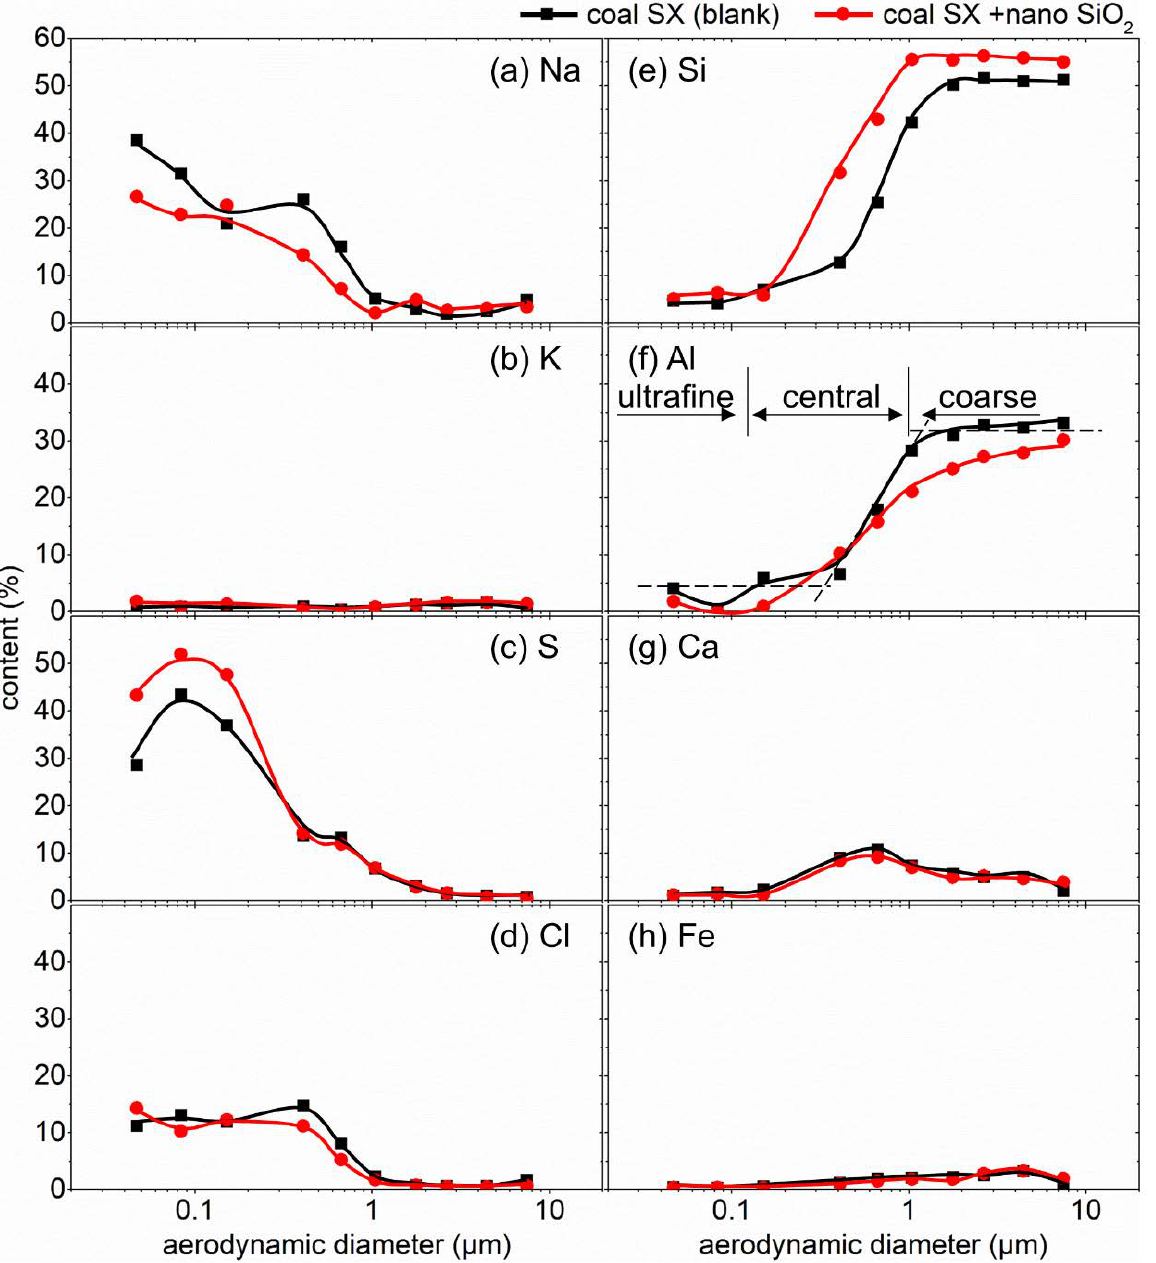
Figure 3. Size-resolved elemental composition distribution in PM 10 generated from coal SX combus- tion with/without nano SiO 2 addition: ( a ) Na; ( b ) K; ( c ) S; ( d ) Cl; ( e ) Si; ( f ) Al; ( g ) Ca; ( h ) Fe.